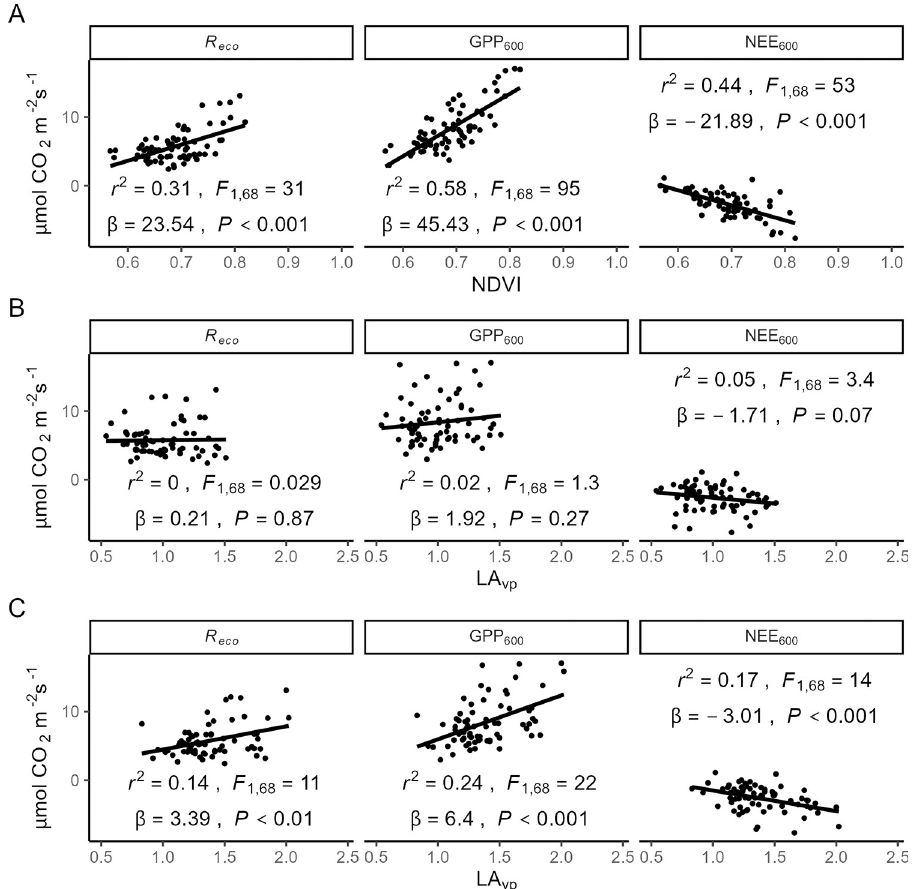
Fig 5. The relationship between components of peak-season plot-level CO 2 exchange in the MAT sample plots and NDVI (A), LA VP calculated without moss contributions (B), and LA VP calculated with moss (C). Goodness-of-fit and model statistics are